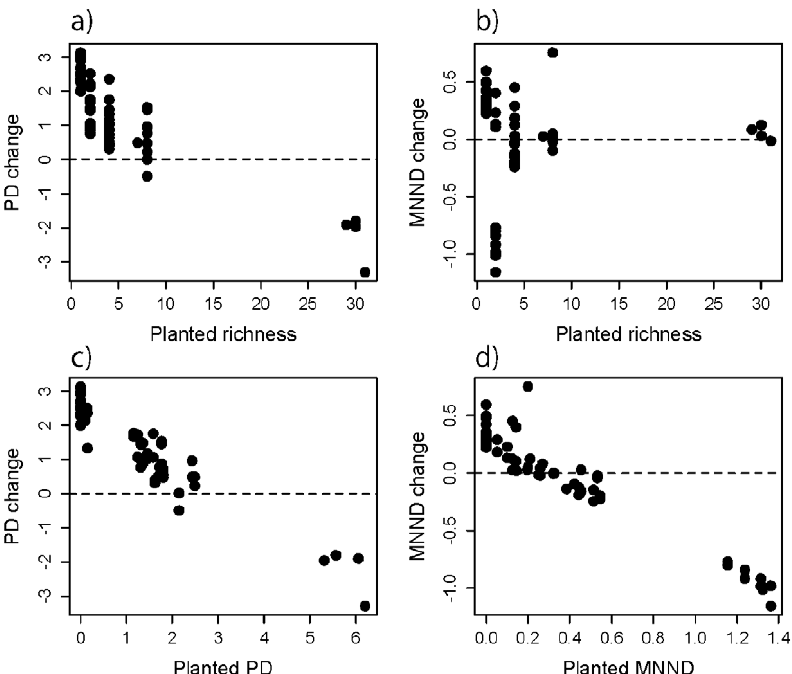
Figure 3. The relationship between planted diversity and diversity change in the experimental plots. Plot PD generally declined with the number of species planted (a); there was substantial change in MNND for the low diversity plots, but little change in mean MNND (b); and there appeared to be a linear relationship between planted PD and PD change (c), and between planted MNND and MNND change (d).